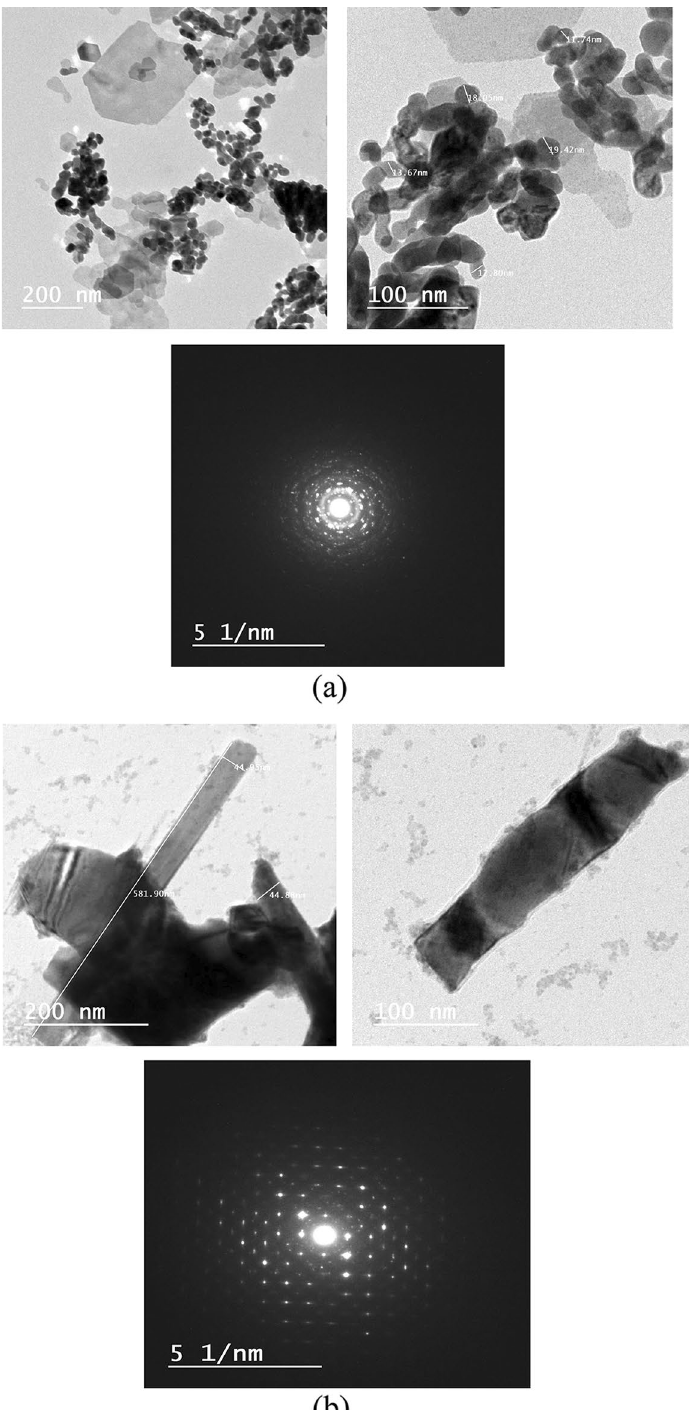
Figure 5. ( a ) TEM of Er-doped PEZT of thin film sample. ( b ) TEM of Er-doped PEZT nano-rods of bulk crystallinity and made the film more dense by minimizing imperfections, the dielectric loss of the film was lower than that of the bulk sample 29,31–33 . Ferroelectric properties. Figure 8a,b shows the PEZ and PEZT samples (thin film and bulk) ferroelectric characteristics. When loaded at a frequency of 1000 Hz, Fig. 8a illustrates the polarization hysteresis loops of PEZ and PEZT films with doped Er, respectively. Figure 8a exhibits polarization and electric field direction were